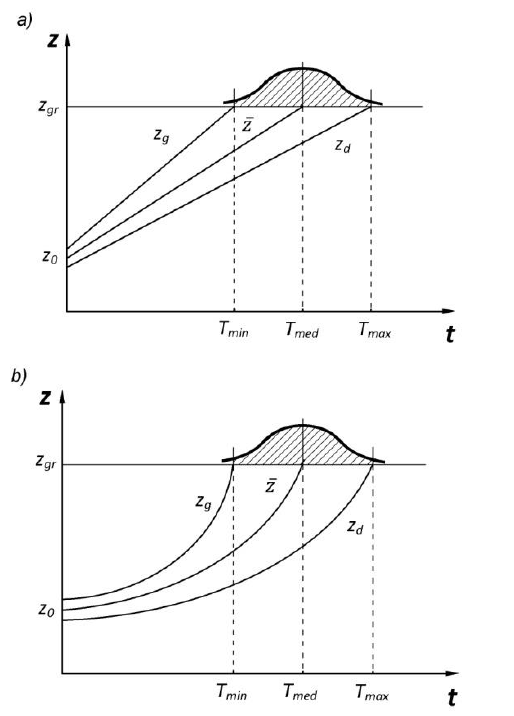
Fig. 2. Schematic presentation of durability assessment using a’priori